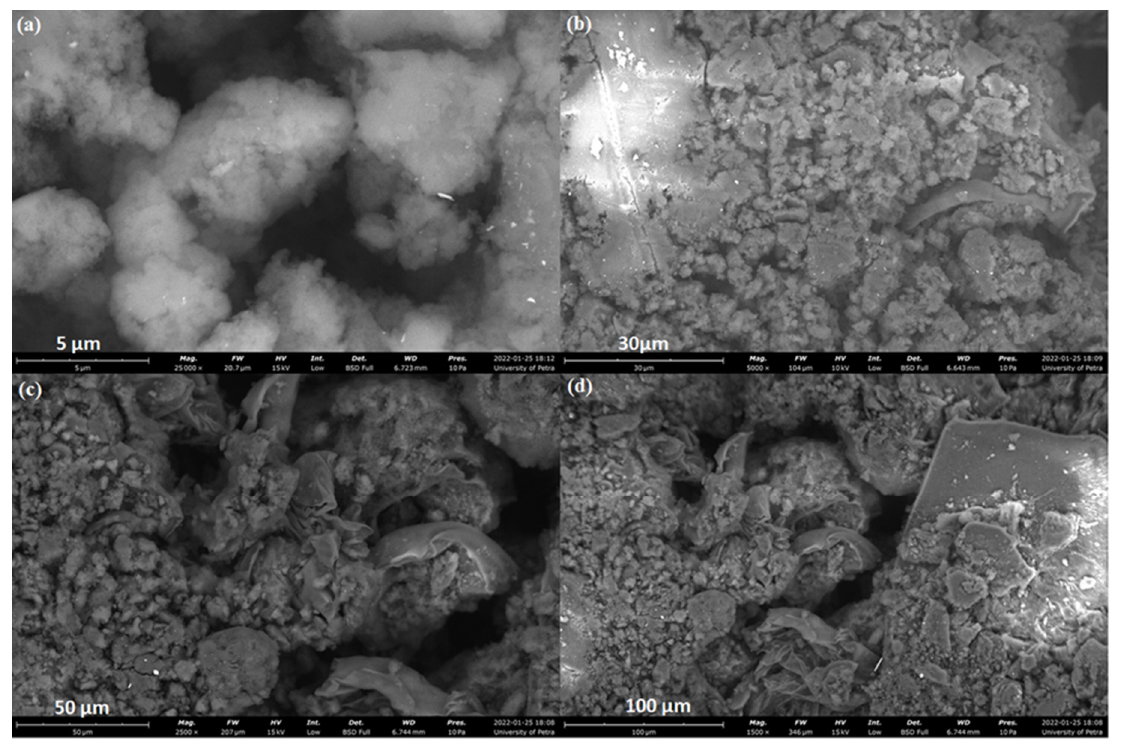
Figure 7. SEM micrographs of the hyperbranched polyester ( a ) 5 µm ( b ) 30 µm ( c ) 50 µm ( d ) 100 µm.